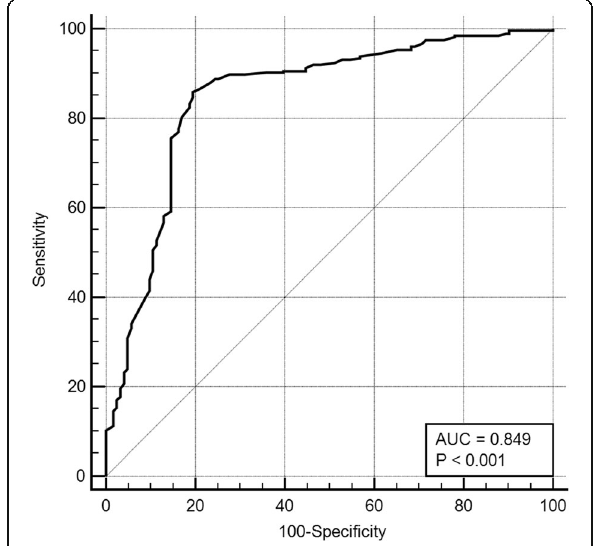
Fig. 3 The receiver operating characteristic curve of the 24-h AFPC percent